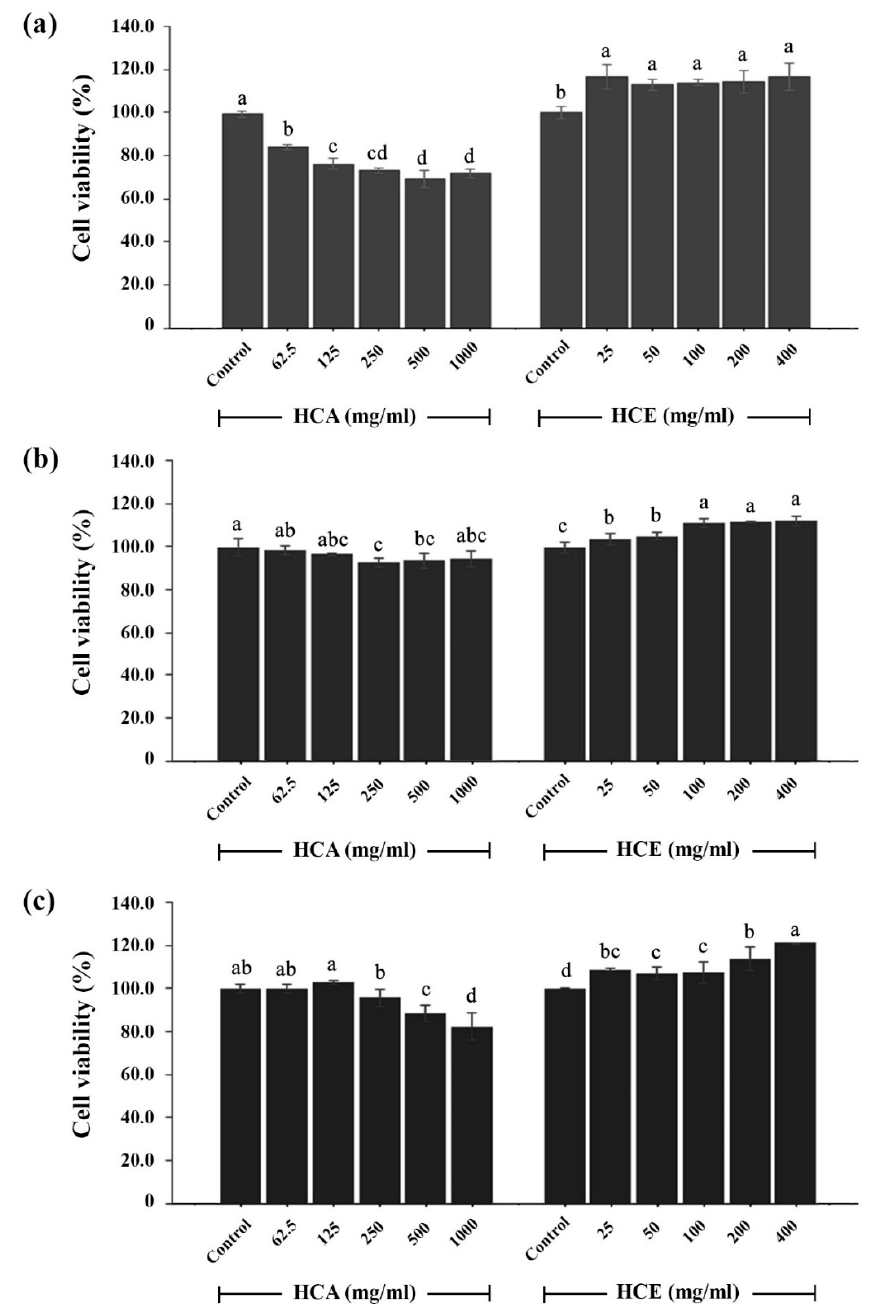
Figure 2. Cytotoxicity activities of H. cordata extracts with different concentrations determined by MTT assay. Mouse macrophages (RAW 264.7) ( a ), human keratinocytes (HaCat) ( b ), human fibroblasts (NHDF) ( c ) were used for the assay. The different letters among the bars indicate that the values of the bars are significantly different ( p <0.05). On the other hand, if some bars have same letters, it indicates that the values of the bars are not different ( p > 0.05).